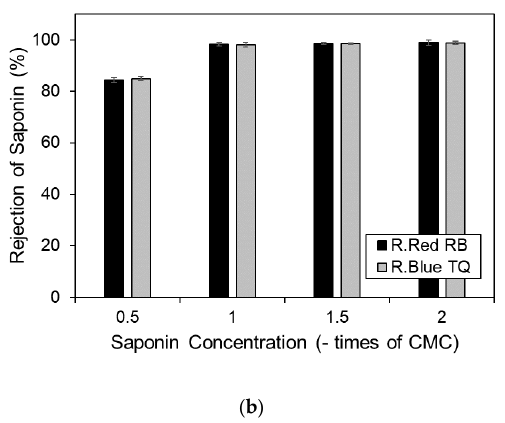
Figure 4. Rejection of Remazol dyes at various saponin concentrations (0, 0.5, 1, 1.5, and 2 × CMC), ( a ) rejection of dye, ( b ) rejection of saponin. ( a ) rejection of dye, ( b ) rejection of saponin.